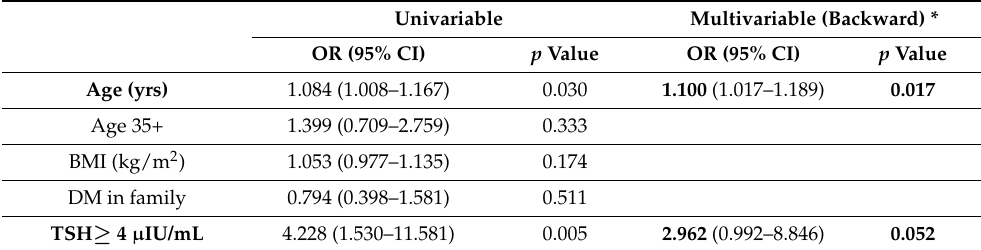
Table 7. Univariable and multivariable